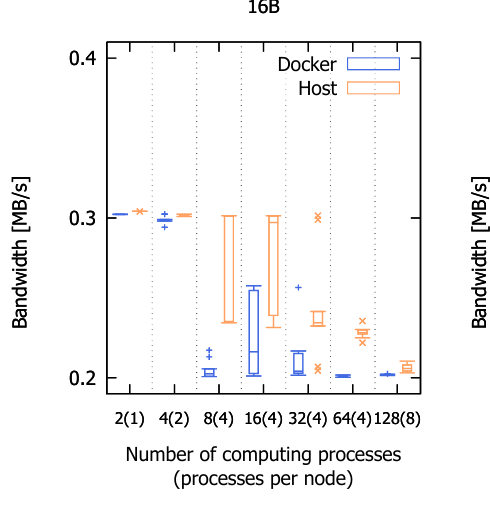
Figure 17. Hardware counters for SPMD program with -O3 and -march=native compilation parameters; boxplot notation: medians, Q1 and Q3, max(Q1 − 1.5IQR, minimum) and min(Q3+1.5IQR, maximum) as well as potential outliers (+ for Docker, x for Host).